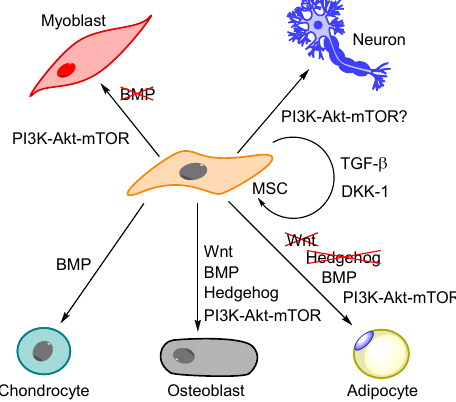
Figure 3. Mesenchymal stem cell self-renewal and differentiation. Transforming growth factor β